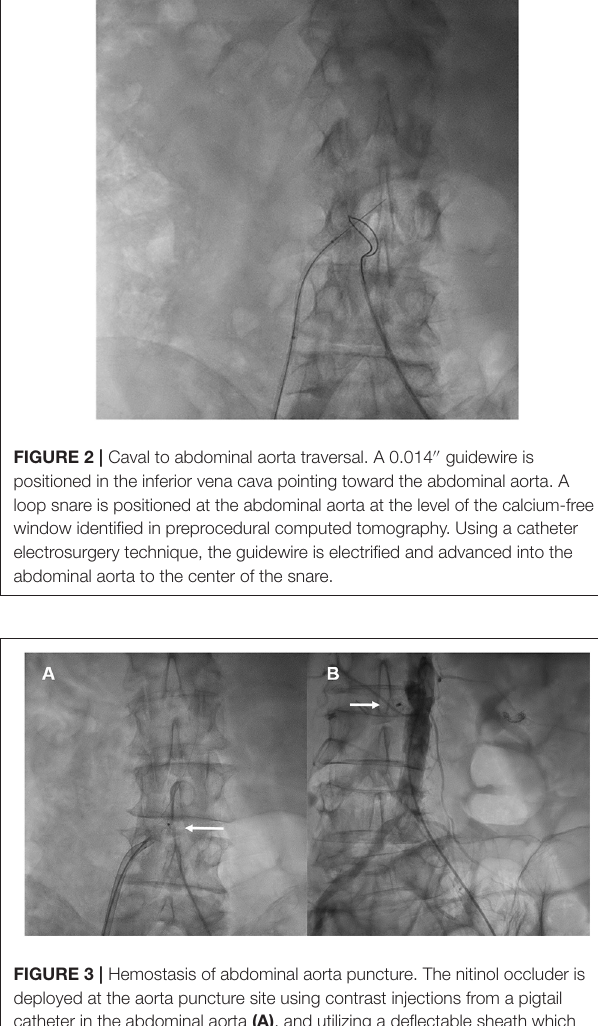
inflations are performed (AltoSa XL PTA Balloon;